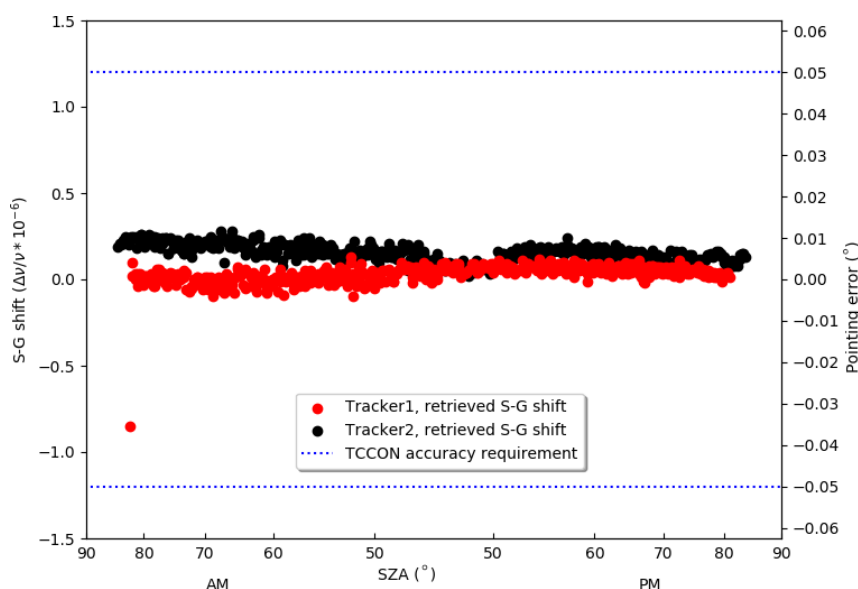
Figure 10. Indicative accuracy of two solar trackers, inferred using S-G shift analysis under clear sky conditions during spectrometer inter- comparison, 29 March 2019. “Tracker1” and “Tracker2” are local tracker identifier names. The dotted blue line indicates TCCON accuracy specification.